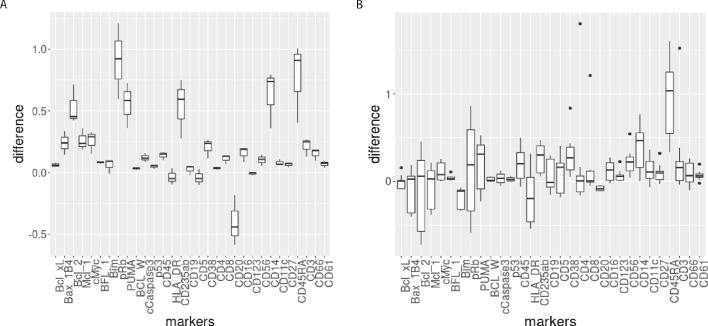
Boxplot of the differences of median protein expression differences across batches before and after CytofRUV normalisation (ΔΔ, see Materials and methods) with k=5 within the main prominent cell subpopulation.(A) ΔΔ differences were computed on the 3 replicated CLL samples within the main CLL cluster. (B) ΔΔ differences were computed on the 9 replicated HC samples within the main HC cluster.